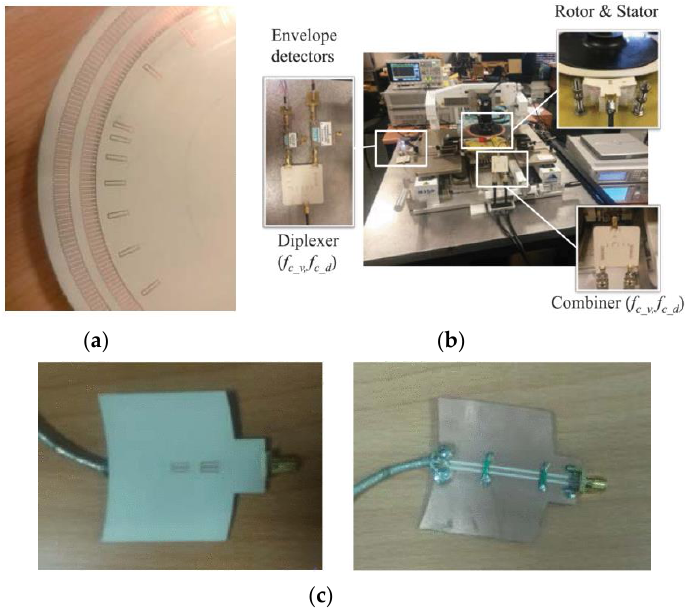
Figure 19. Photograph of the rotor ( a ), experimental set-up ( b ), and stator ( c ). From [30], reprinted with permission.